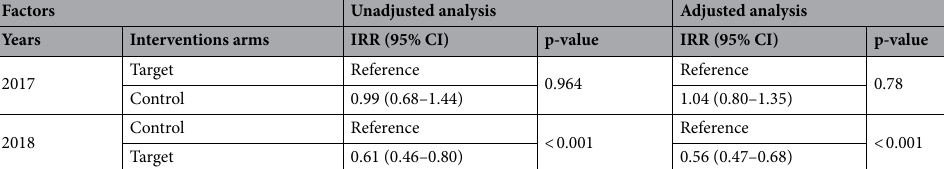
Table 2. Results of the unadjusted and adjusted negative binomial regression analyses of Anopheles gambiae s.l. density per house compared between control and target arms in 2017 and 2018. IRR (95% CI) correspond to the Incidence rate ratios (IRR) with 95% confidence intervals (95% CI) from unadjusted and adjusted negative binomial regression analyses.